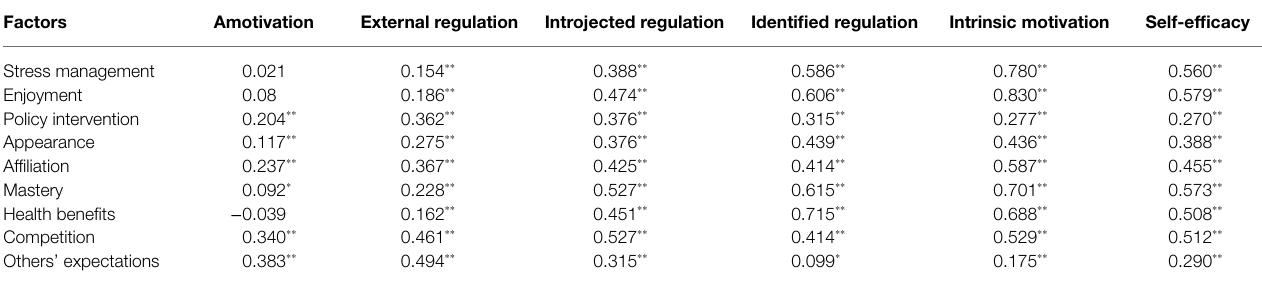
TABLE 8 | Pearson’s correlation coefficients between the CUSPAMS subscales and different dimensions of C-BREQ-2 and SEE-C (sample 3).